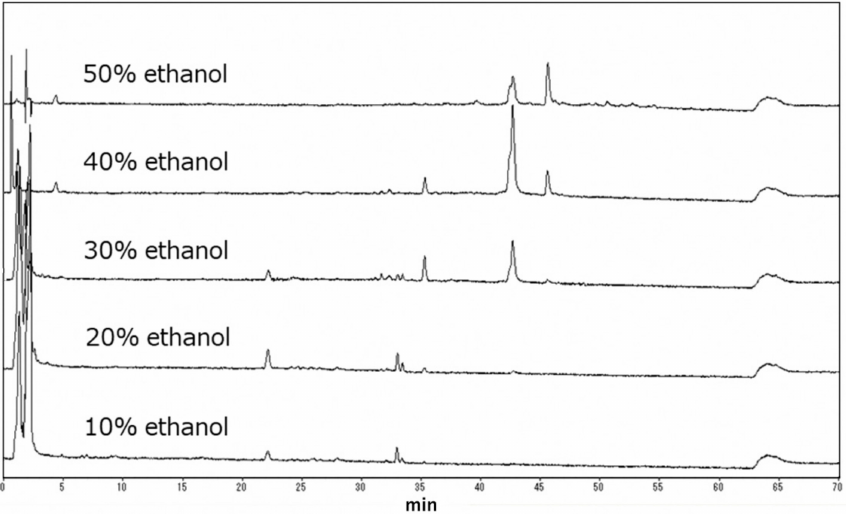
Figure 1. High-performance liquid chromatography (HPLC) chromatograms for the Vaccinium oldhamii fractions separated by synthetic